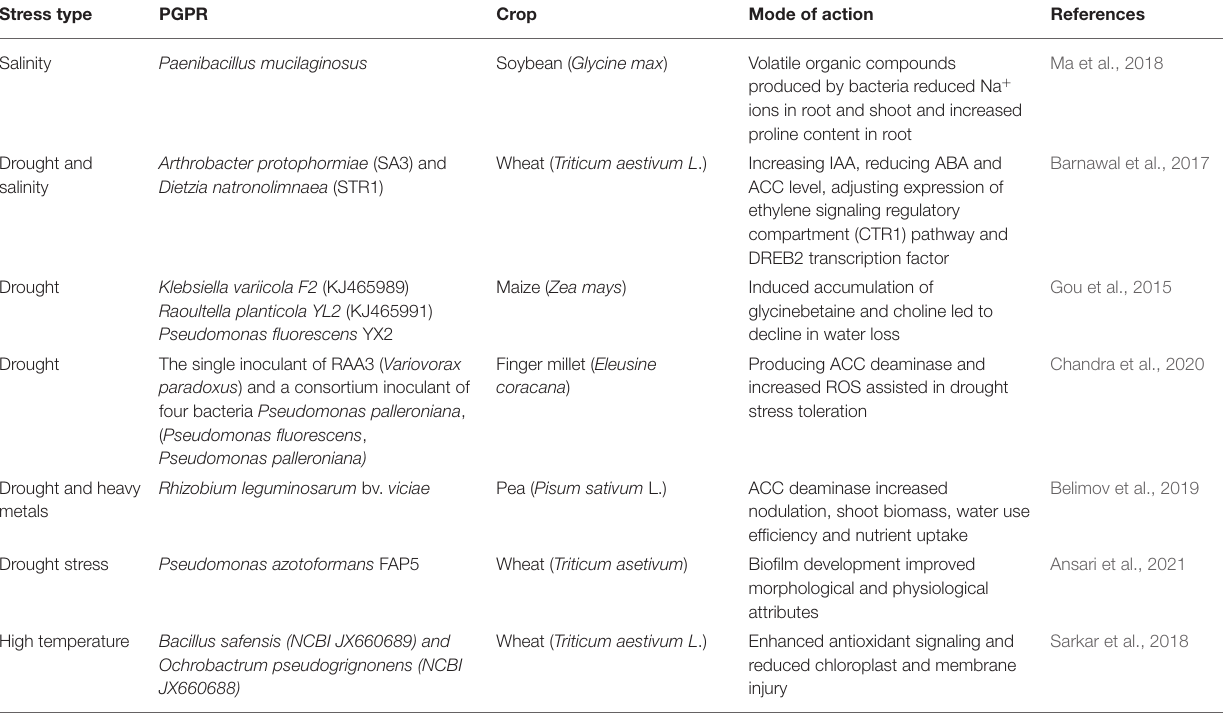
TABLE 1 | Crop abiotic stress amelioration by PGPR.